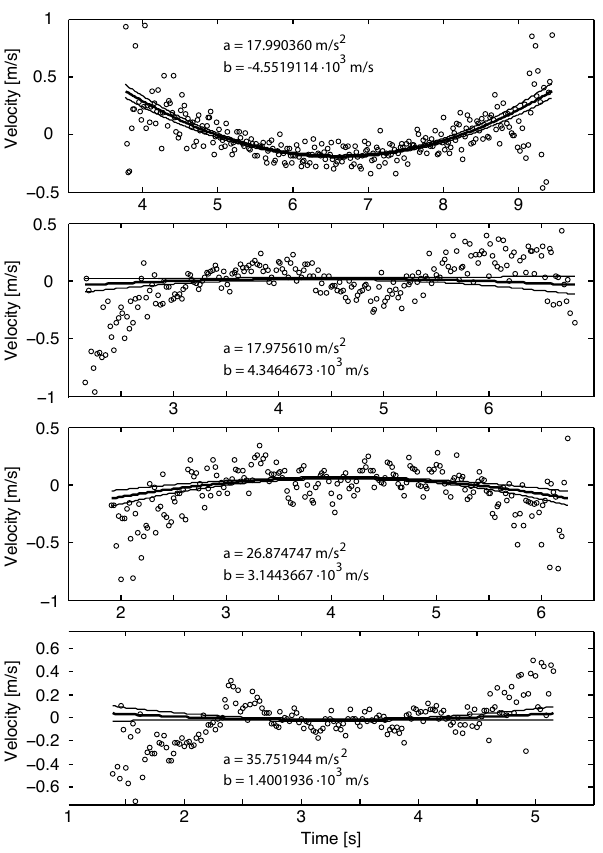
Fig. 4. Detrended velocities calculated from the Doppler frequen- cies shown in Fig. 3 (open circles), together with velocities fitted to / 2 (heavy line). The 3 σ limits of the the model v i = v 0 + a 0 t i + ˙ at 2 i fitted velocity are shown by the thin lines. The subtracted trend is v L = a · t + b with the numbers given in each panel.